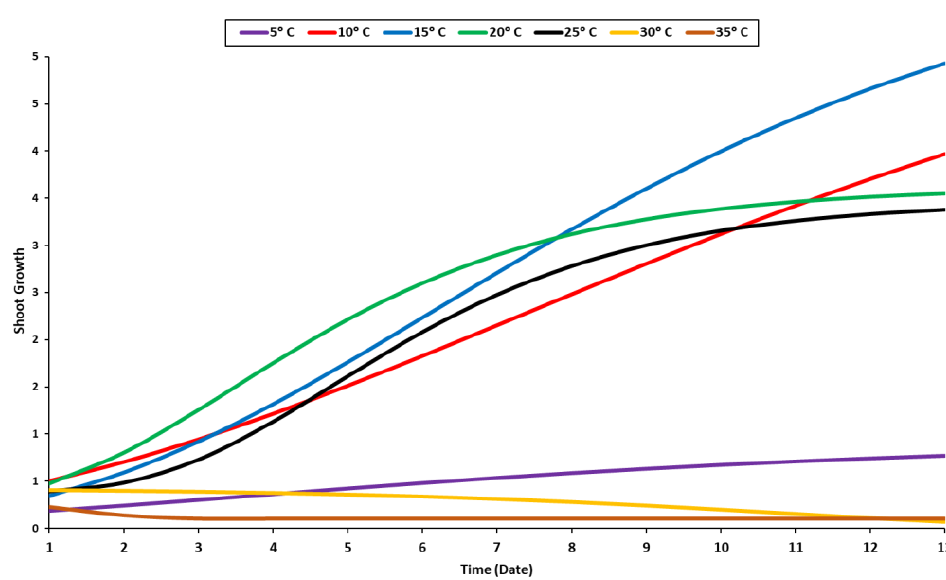
Figure 3. Growth response of shoot to temperature levels.